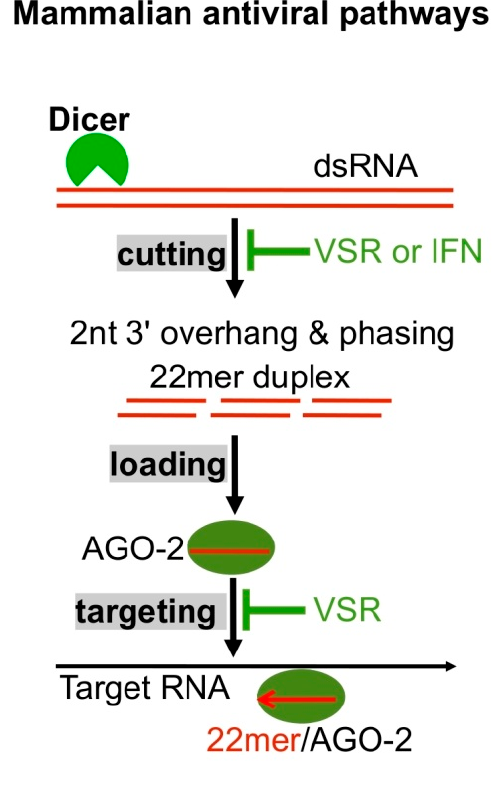
Figure 5. Mammalian antiviral RNAi. Dicer cleaves dsRNAs to generate duplex 22mer siRNAs with a 2-nt 3 ′ overhang, 22mer siRNAs are loaded to Argonaute AGO2 to form RISCs, and RISCs cleave target RNAs. VSR and IFN signaling suppress Dicer activity; VSR also suppresses RISC activity.